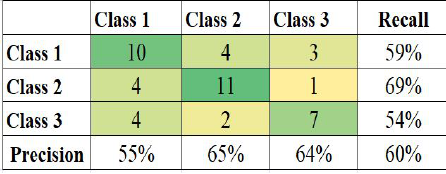
Figure 5. The overall accuracy attained by the classifier for Ecuador is 60%. Class 2 has the maximum correct predictions; wheres class 3 happens to miscategorize significant unseen samples.